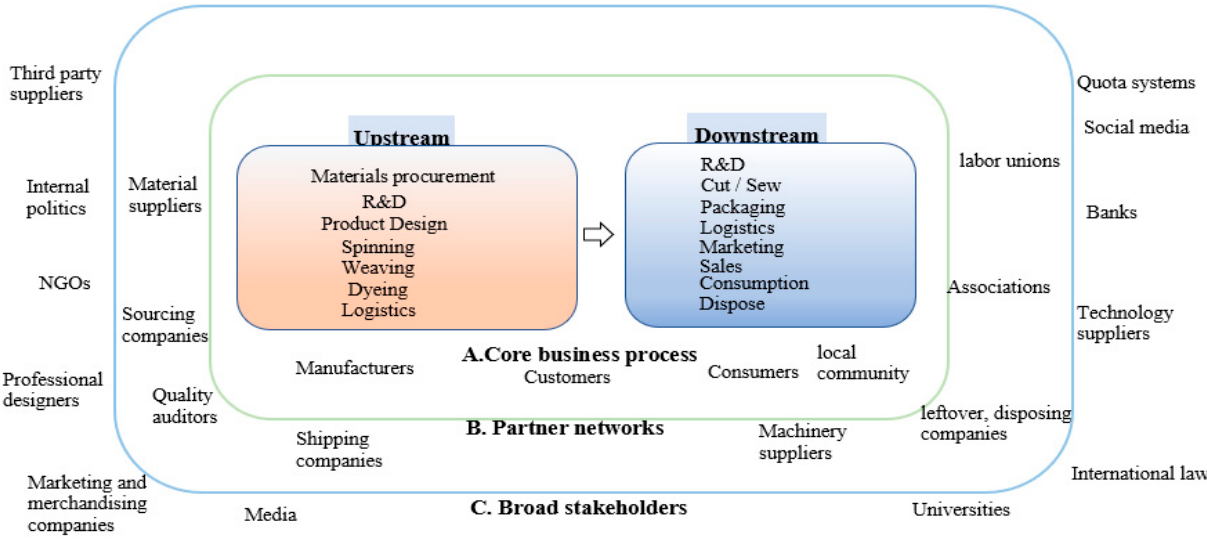
Figure 10. Relative importance of stakeholders in the Amazon fashion business. Source; Authors.